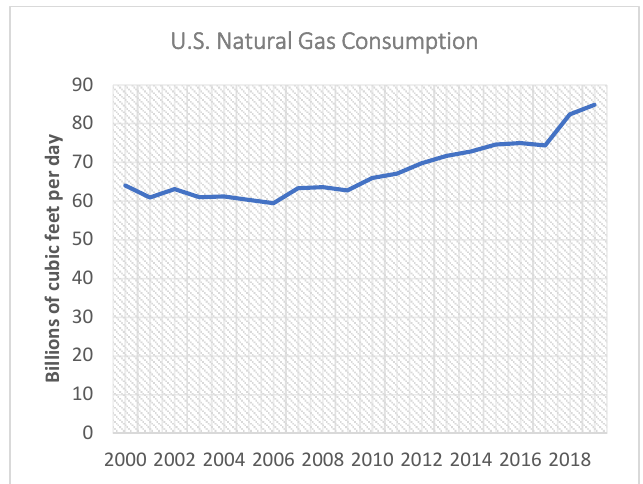
Figure 1. U.S. natural gas consumption, 2000–2019. Data source: U.S. Energy Information Administration.